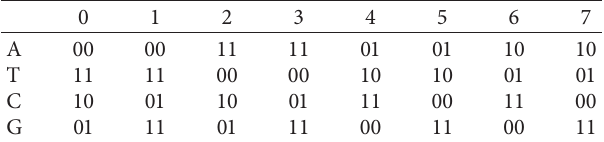
Table 4: Binary versus DNA coding